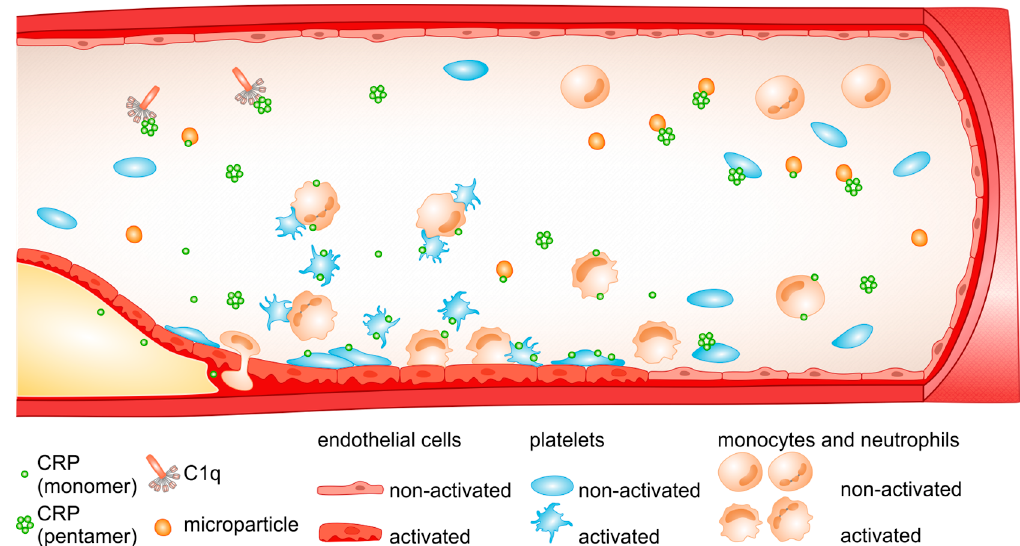
Figure 1. Possible interactions of CRP with blood cells and plasma components. Pentameric CRP (nCRP) bound to microbial polysaccharides or ligands exposed on damaged cells activates the classical complement pathway through the interaction with C1q. Both pro-and anti-inflammatory effects are attributed to nCRP via its interactions with blood cells (for details, please see Section 3). At the site of the injured endothelium, circulating platelets undergo activation and spread. On the surface of the activated platelets, circulating cell-derived microparticles and apoptotic cell membranes, pentameric CRP dissociates to monomeric CRP (mCRP), which exerts pro-inflammatory effects by activating blood cells and by promoting inflammatory response. mCRP can be deposited in atherosclerotic lesions.